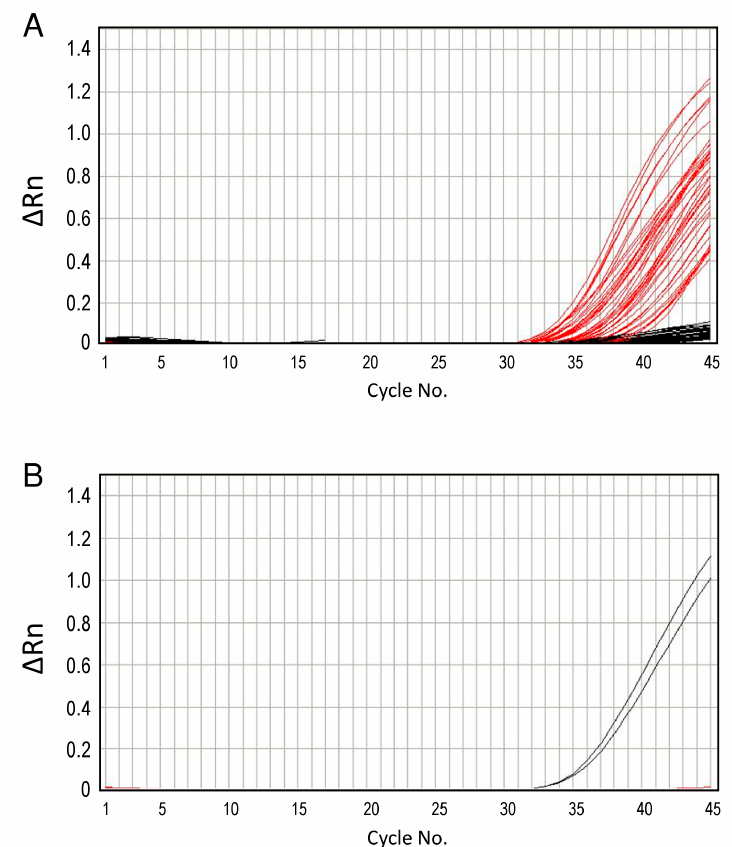
Figure 5. Detection of Borrelia DNA from tick specimens by real-time PCR. PCR positive by NWB_VIC_1794 (red line) and OWB_FAM_1795 (black line) probes were shown in ( A , B ), respectively. Each tick specimen was examined in duplicate in this study.